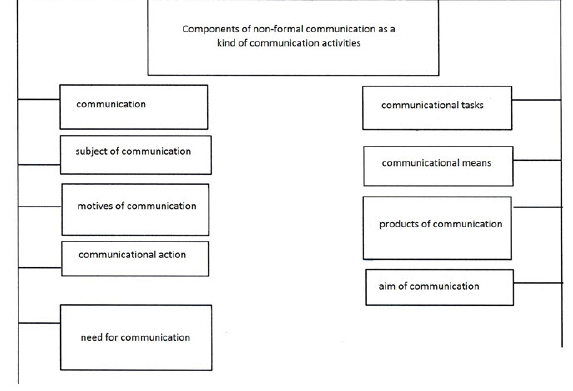
Figure 2. Components of non-formal